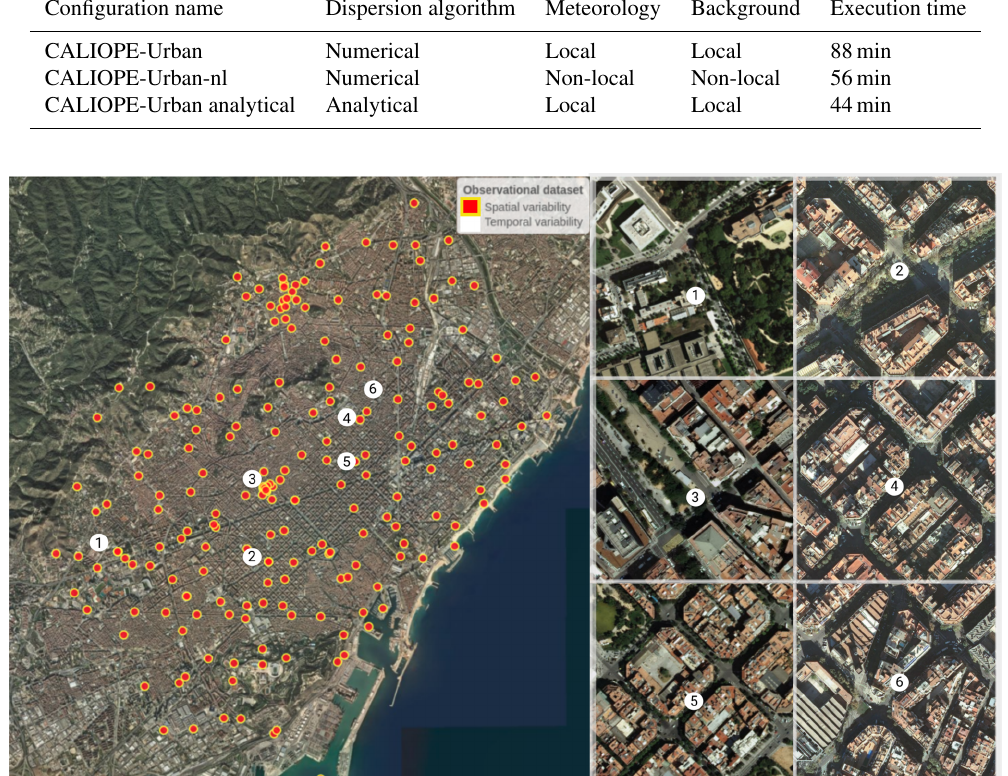
Figure 6. Passive dosimeter and monitoring site locations used in the evaluation of CALIOPE-Urban in this work. Red dots with a yellow border represent passive dosimeters (spatial performance) and white numbered dots depict monitoring site emplacements (temporal variabil- ity). White dots numbered 1 (Palau Reial), 2 (Eixample) and 3 (Gràcia-Sant Gervasi) are air quality monitoring sites and 4 (213 Industria Street), 5 (445 Valencia Street) and 6 (309 Industria Street) correspond to mobile units. Basemap source: Esri